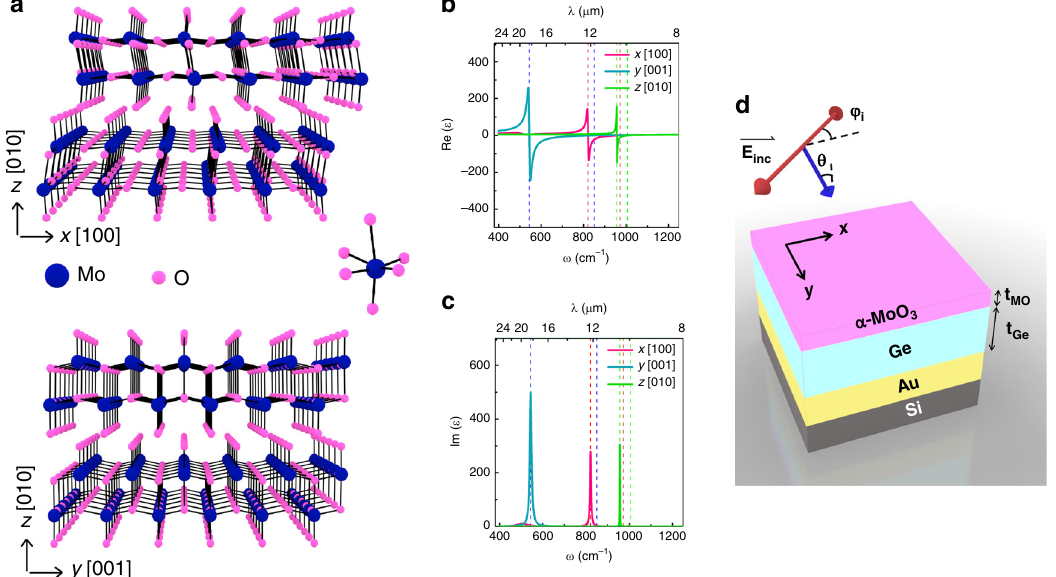
Fig. 1 Optical characteristics of α -MoO 3 and the structure under study. a Schematic representation of atomic orientation in the bulk structure of α -MoO 3 in xz and yz planes, ( b ) real and ( c ) imaginary parts of the dielectric function for α -MoO 3 . d Schematic illustration of the investigated multilayer